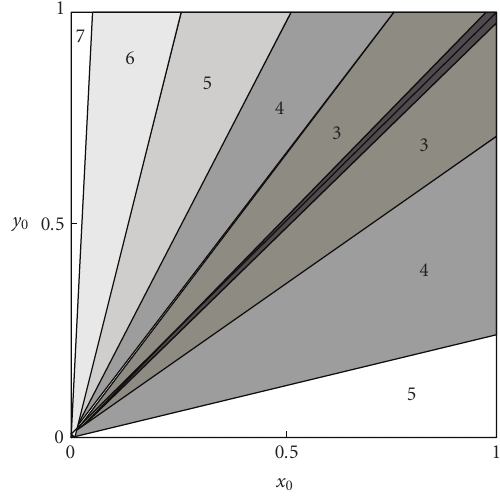
Figure 5.2. Number of iterations with critical exponent δ =